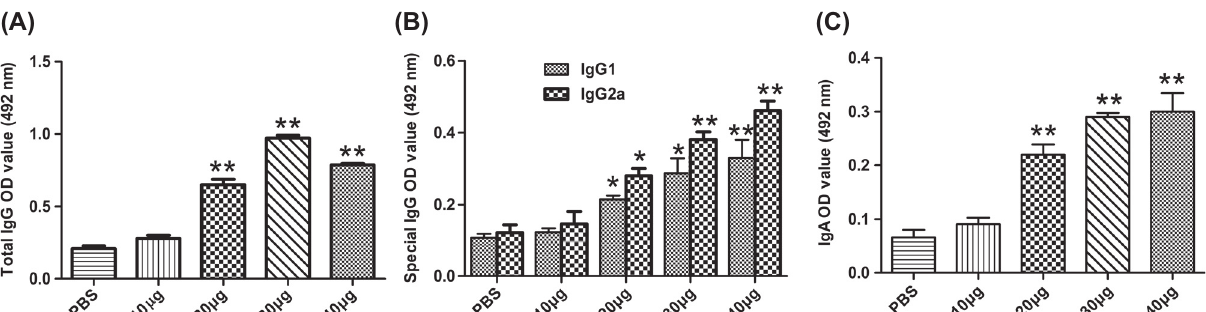
Figure 1. Determination of specific anti-rTgPGAM 2 humoral response in BALB/c mice. Two weeks after the immunisation schedule was completed, blood samples were obtained and antibody titres were determined by ELISA with rTgPGAM 2 as the bound target. The specific total IgG (A), IgG isotype (B) and IgA titres (C) in sera from mice vaccinated with different dosages of rTgPGAM 2 or PBS as a control were determined in duplicate. The results are expressed as the mean of the OD 492 ± SD ( n = 10) and are representative of three experiments. * P < 0.05, ** P < 0.01 (vaccinated vs. PBS